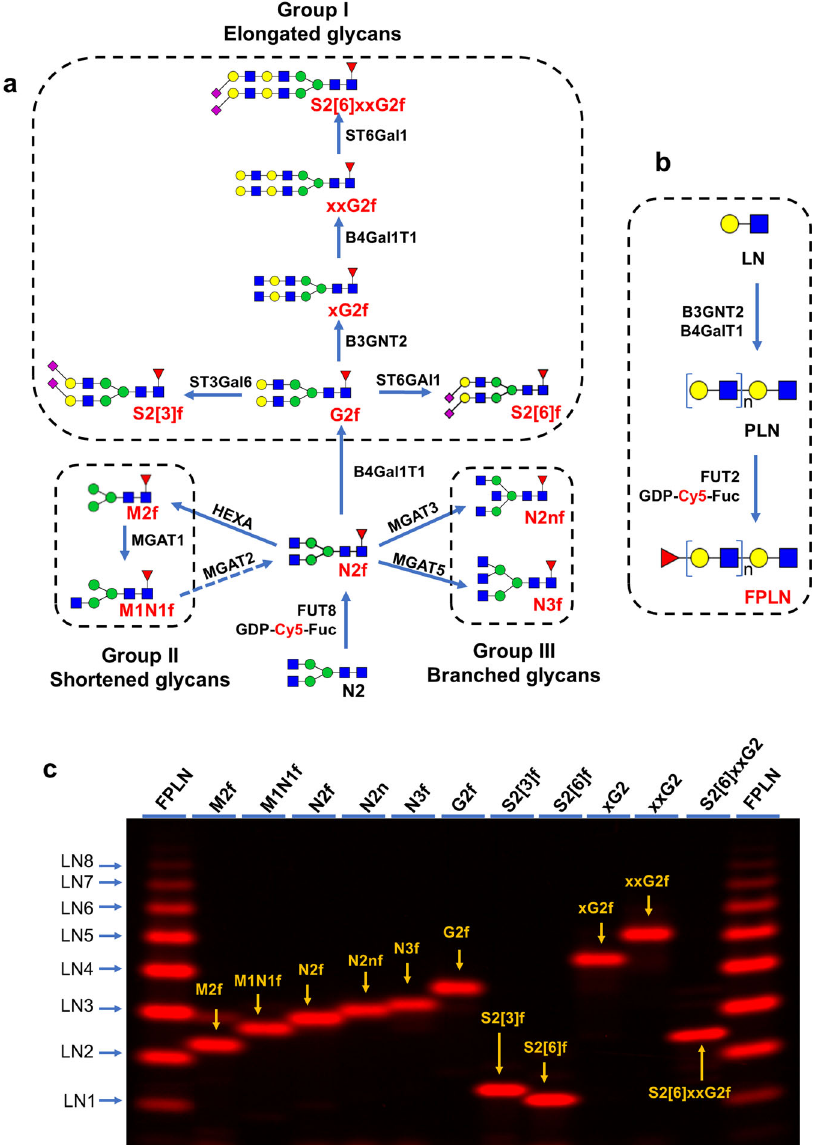
Fig. 2 Enzymatic synthesis of all the glycan substrates for this study. a Schemes for the synthesis of all the substrate glycans in this study. Glycans were enzymatically synthesized starting from Cy5-Fuc labeled N2f. N2f can be converted from M1N1f by MGAT2 (shown with dotted line). These glycans are separated into three groups: Group I, elongated glycans; Group II, shortened glycans; Group III, branched glycans. For clarity, bond linkages are not shown. b Scheme for Cy5-Fuc labeled polylactosamine (FPLN) synthesis. c The synthesized glycans along with FPLN were separated on a 17%